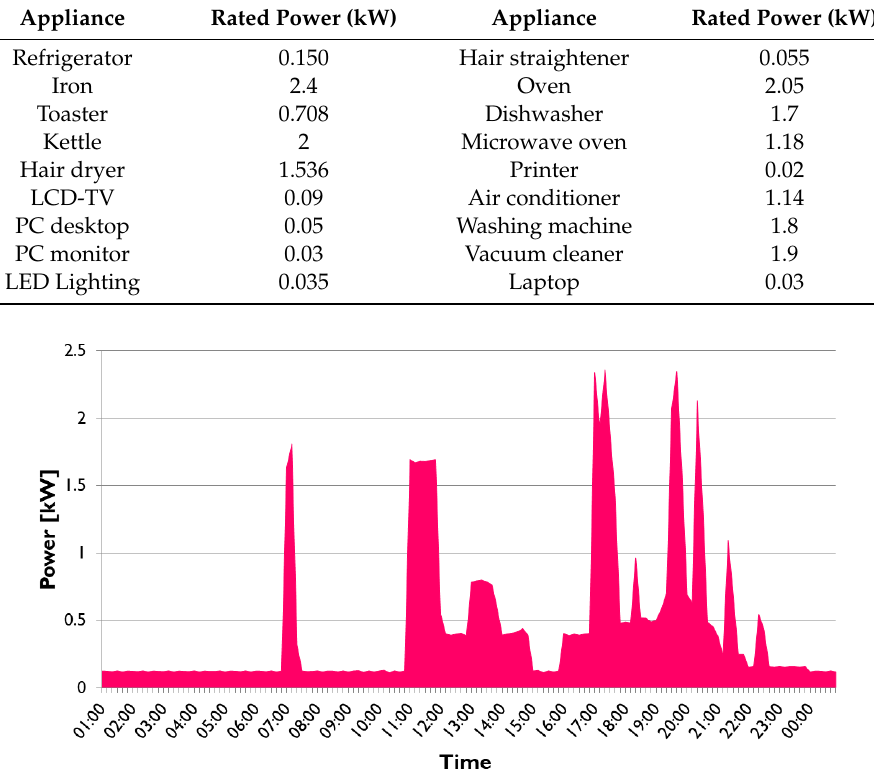
Figure 2. The power consumption of smart home based on real measurements considering harmonic